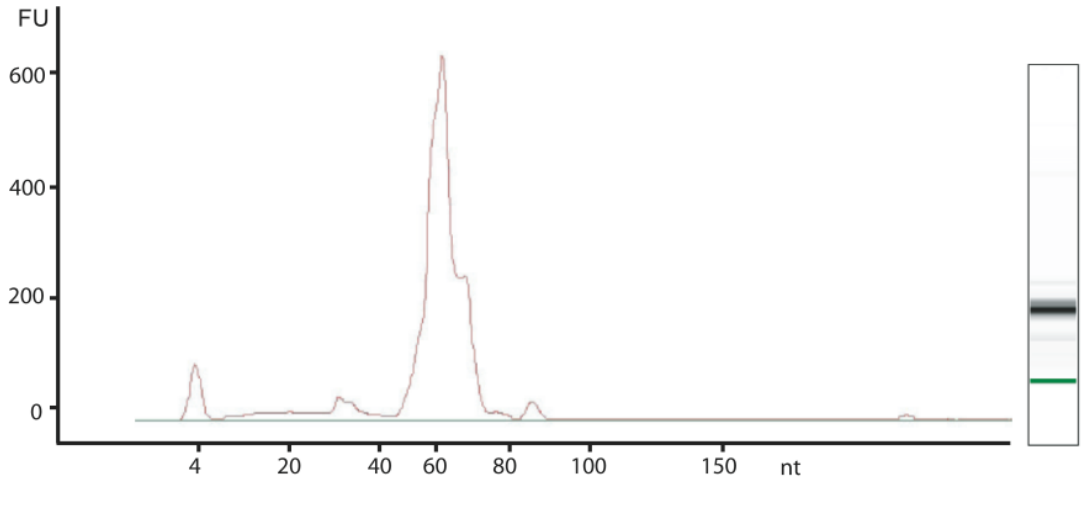
Figure 1. Characterization of BCG small RNA species. An aliquot of small RNA isolated from BCG was analyzed on an Agilent Bioanalyzer small RNA chip. The peak at 4 nt in the electropherogram represents a size standard; the image on the right is the reconstructed gel image of the resolved RNA